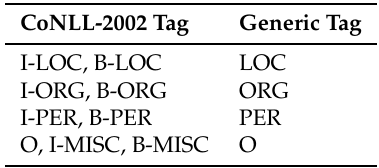
Table 4. Named entity tags used in the training